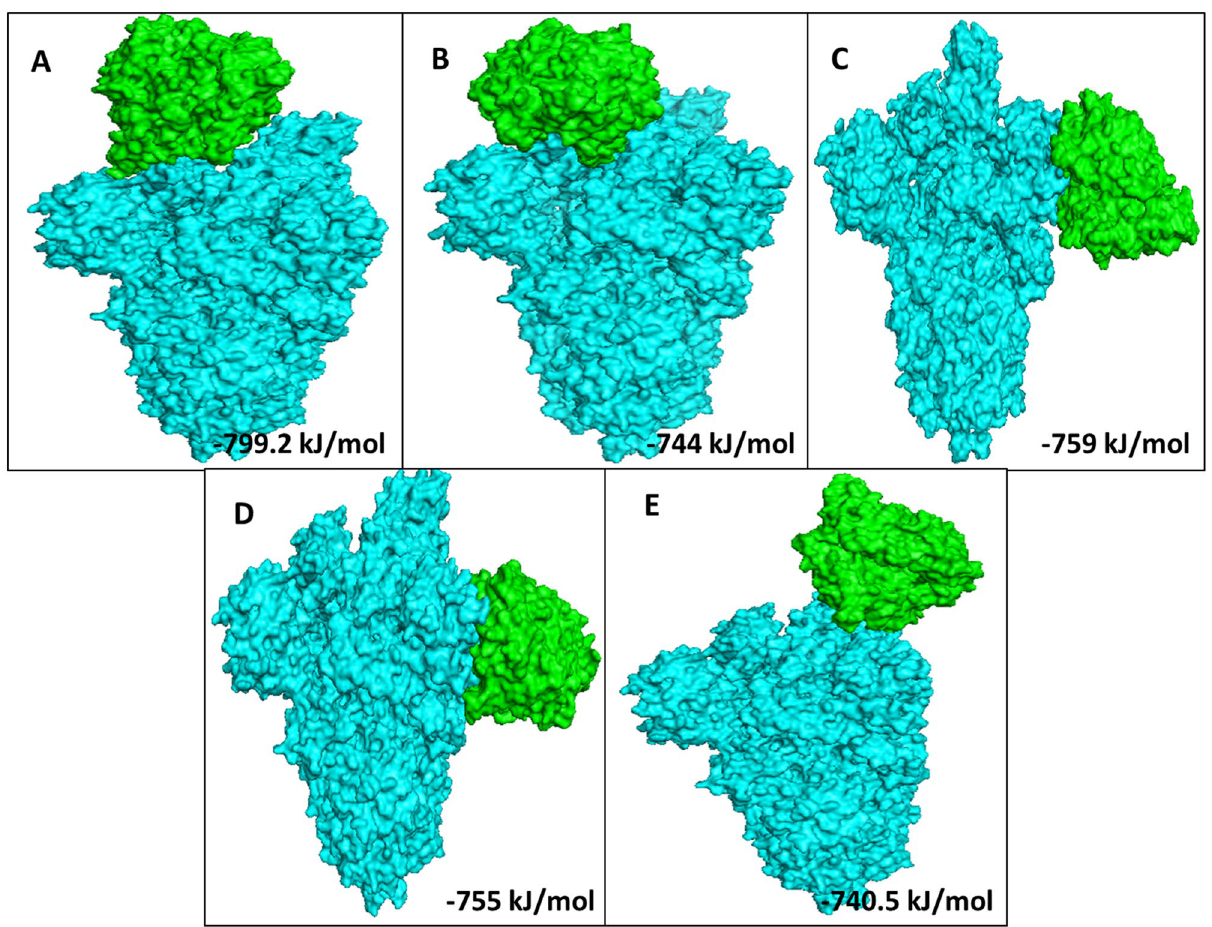
Figure 3. The top 5 docked models displaying interaction of S Protein with ACE2 receptor in the presence of MM-GBSA free energy calculation for both polyphenols with S Protein indicates a favourable binding energy for the curcumin (− 53.63 kcal/mol) as compared to catechin (− 34.22 kcal/mol). Average RMSD of both complexes (S Protein–catechin complex and S Protein–curcumin complex) was recorded less than 3 after stabilization of S Protein RMSD. On the contrary, RMSD of S Protein–catechin complex was initially unstable for the first 50 ns Å and stabilised thereafter for the rest of the simulation period (Supplementary Fig. S11). Maximum structural fluctuation was observed in between 300 and 500 amino acid residues and after 1000 amino acids residues of S Protein (Supplementary Fig. S10). The above data supports that S Protein and catechin interaction occurs with amino acid residues of S Protein near the RBD site (319 aa–591 aa) 37 . Amino acid residues Arg634 and Val635 near the RBD site of S Protein have stronger affinity towards hydroxyl group of catechin with 54% and 35%, respectively, out of 100 ns simulation trajectory (Supplementary Fig. S12). The binding affinity of curcumin with ACE2 was noted to be − 7.8 kcal/mol where as that of catechin was found to be − 8.9 kcal/mol. The binding of curcumin or catechin with ACE2 includes conventional hydrogen Bond, carbon–hydrogen bond and Pi–Sigma interactions. The amino acid residues of the protein that take part in the above interactions vary for both ligands (Supplementary Figs. S4, S9 and Table 3). The binding affinity of ‘RBD/ACE2-complex’ with curcumin and catechin scored to be − 7.6 kcal/mol and − 9.1 kcal/mol, respectively. Results of the present investigation suggest that amino acid residues of both the components of ‘RBD/ACE2-complex’ that interact with catechin and curcumin are different. While curcumin binds with the ACE-2 receptor in the complex through van der Waals interactions (Phe390, Asn33, Glu37, His34, Asp38, Lys353, Arg396, Pro389), catechin interacts with ACE2 receptor in the complex through van der Waals interactions (Arg559, Gln338, Ser536, Thr92, Leu29, Val93, Lys26, Asn33, Ala386 and His34), conventional